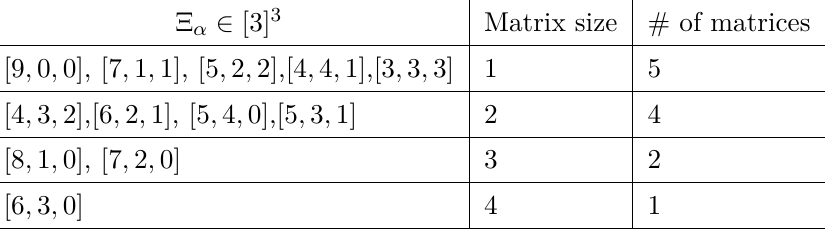
Table 5 . The multiplicity table for Ξ α